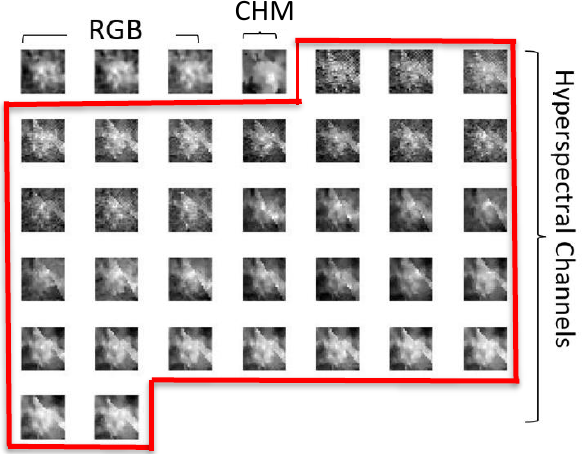
Figure 3. Treetop shape in 37 normalized RGB, canopy height model (CHM), and spectral channels.